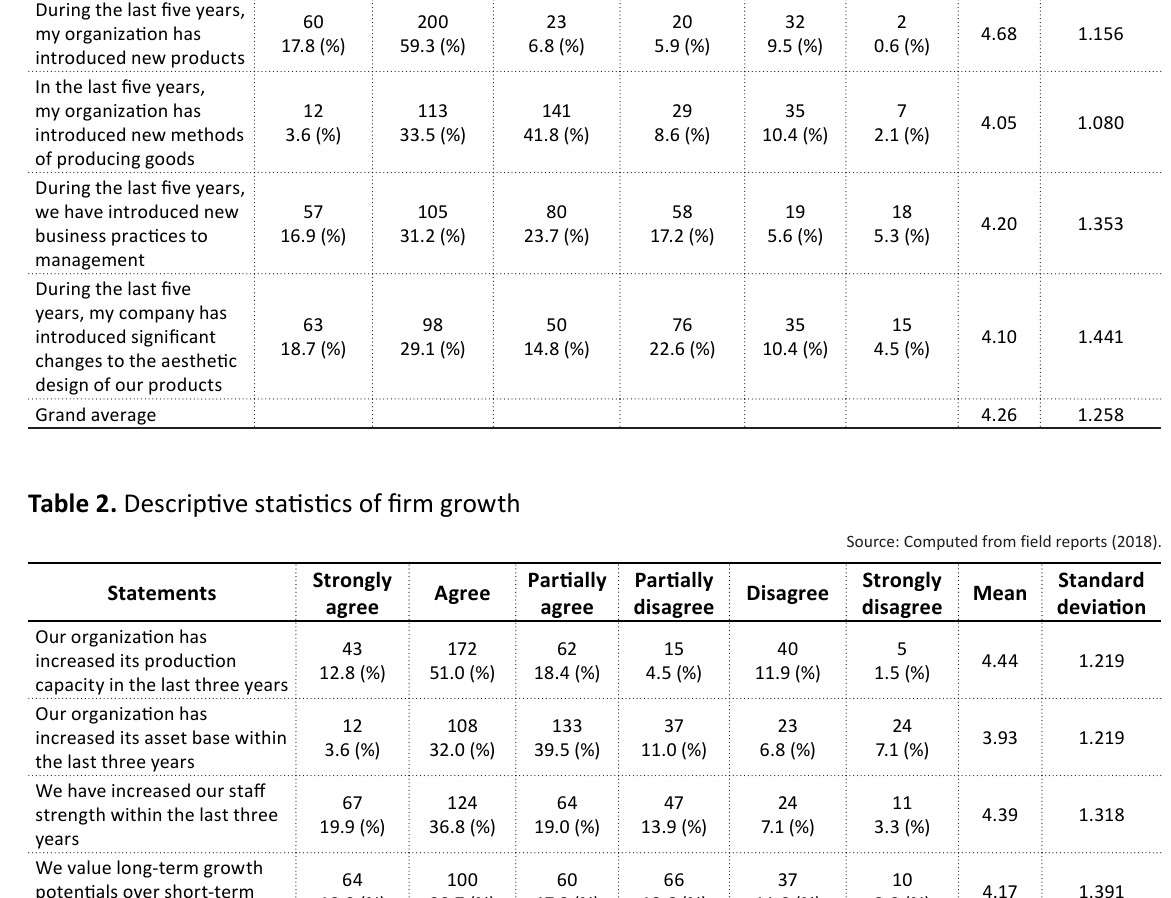
Table 3. Summary of regression analysis of innovation strategy and firms growth